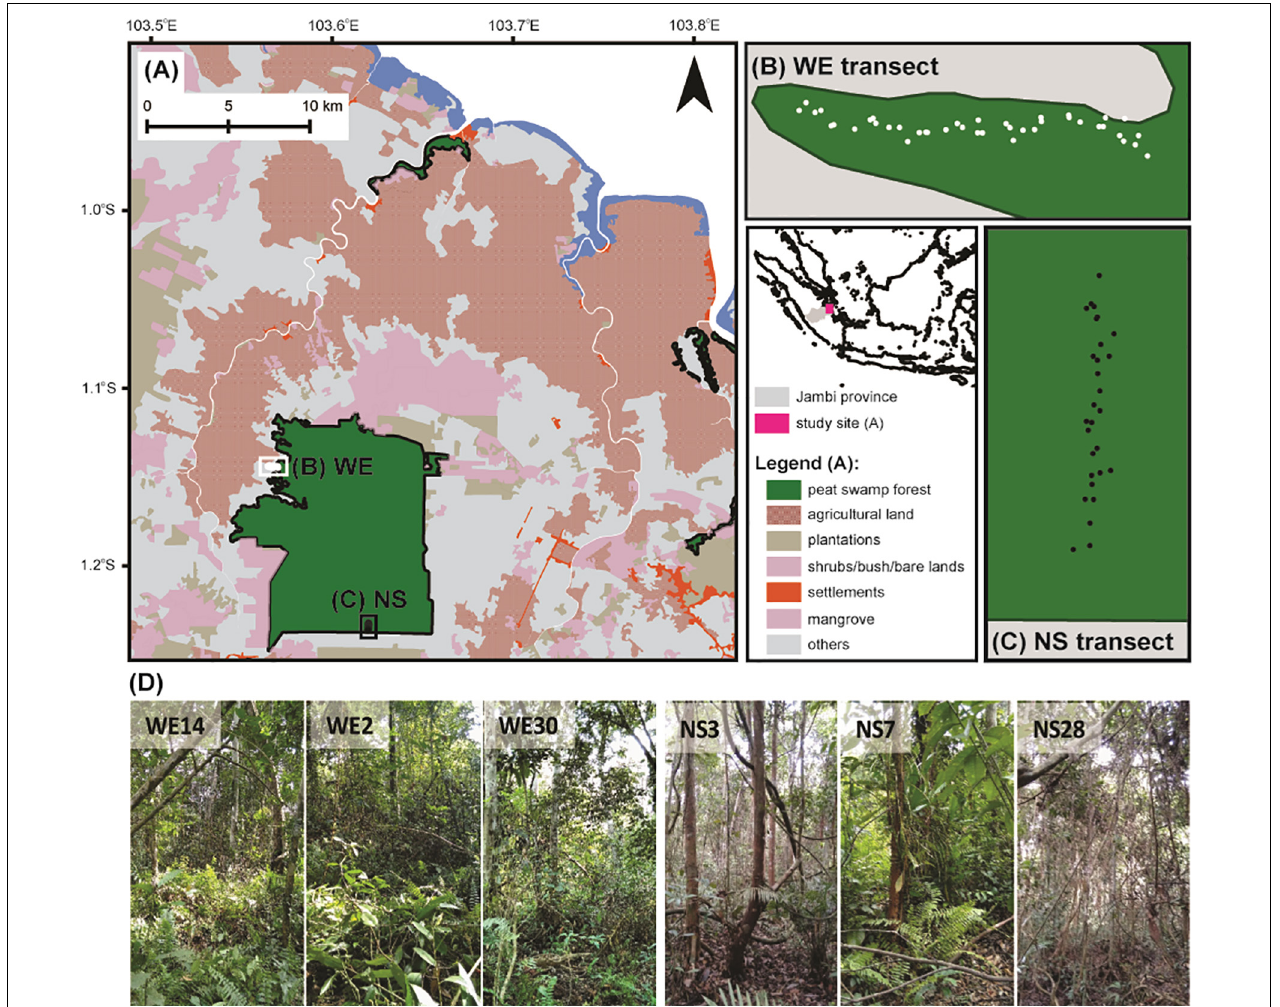
FIGURE 1 | Map of the Sungai Buluh protected peat swamp forest (A) with studied WE (B) and NS (C) transects. Each point on the WE and NS transects indicates the sampling location. (D) Examples of some sampling locations.